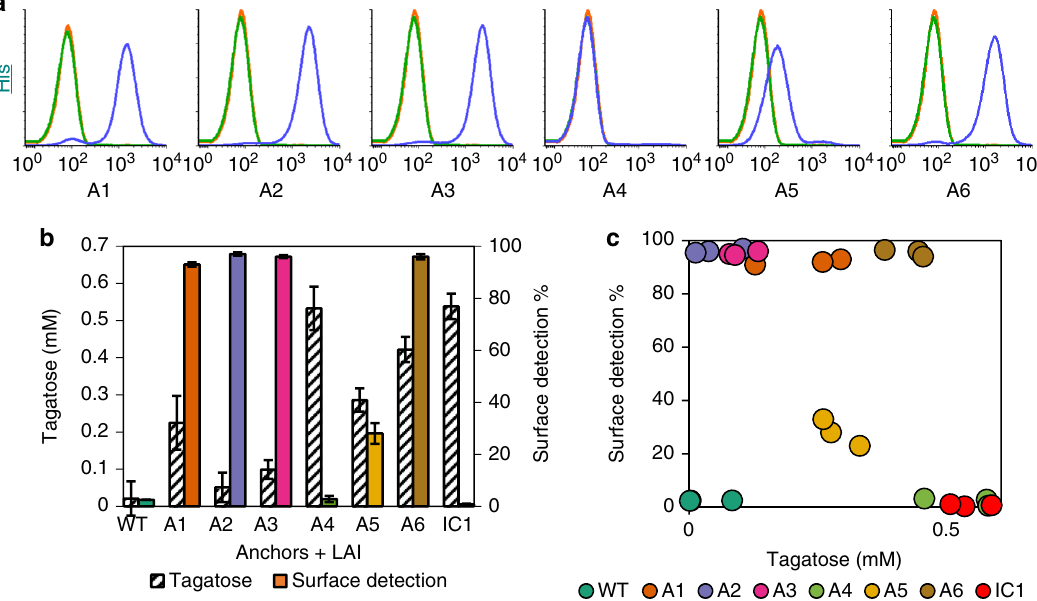
Fig. 2 LsLAI surface display and activity. a Flow cytometry analysis of L. plantarum wild-type cells (green), cells expressing intracellular His 6 -tagged LsLAI (orange), or cells expressing LsLAI fused to native surface anchor proteins A1-A6 for display (blue) with 10 5 counts per sample. Data is normalized to number of counts. b Comparing the amount of tagatose produced from 200 mM galactose in 2 h (hashed) with the positive percentage of the population with surface detection intensity above that of wild-type (WT) for intracellularly expressed IC1 or anchor protein A1-A6 (colored) based on negative gate. c Scatterplot of each replicate measurement correlating surface detection vs. tagatose produced. There is no signi fi cant correlation between the display level and activity based on Pearson Product Moment Correlation test (Correlation coef fi cient = − 0.395, p = 0.0564). The data are means from three biological replicates. The source data underlying Fig. 2 b , c are provided in a Source Data fi